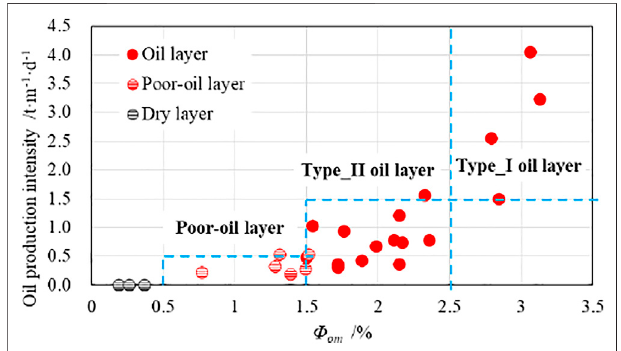
FIGURE 13 | Relationship between Φ om and oil production intensity of the Lucaogou Formation in Jimsar Sag.